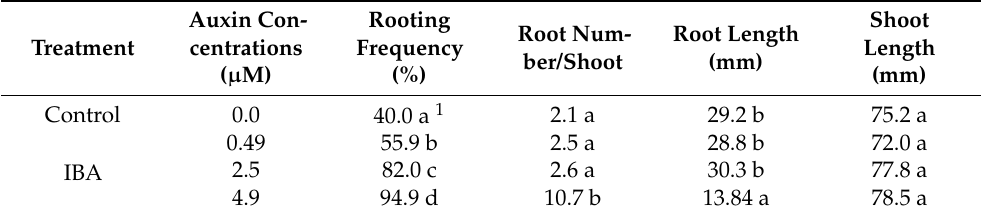
Table 4. Rooting response of rhubarb ‘Malinowy’ shoots after three-week growth in MS medium without auxin (control) and supplemented with IBA at different concentrations (0.49, 2.5, 4.9 µ M).